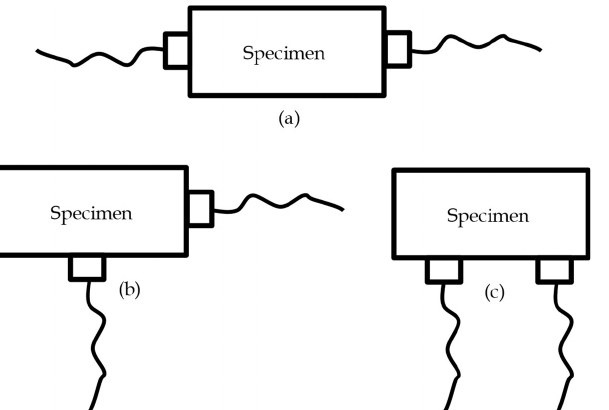
Figure 1. Test setup for UPV, ( a ) direct transmission; ( b ) semi-direct transmission; ( c ) indirect trans- mission. transmission.